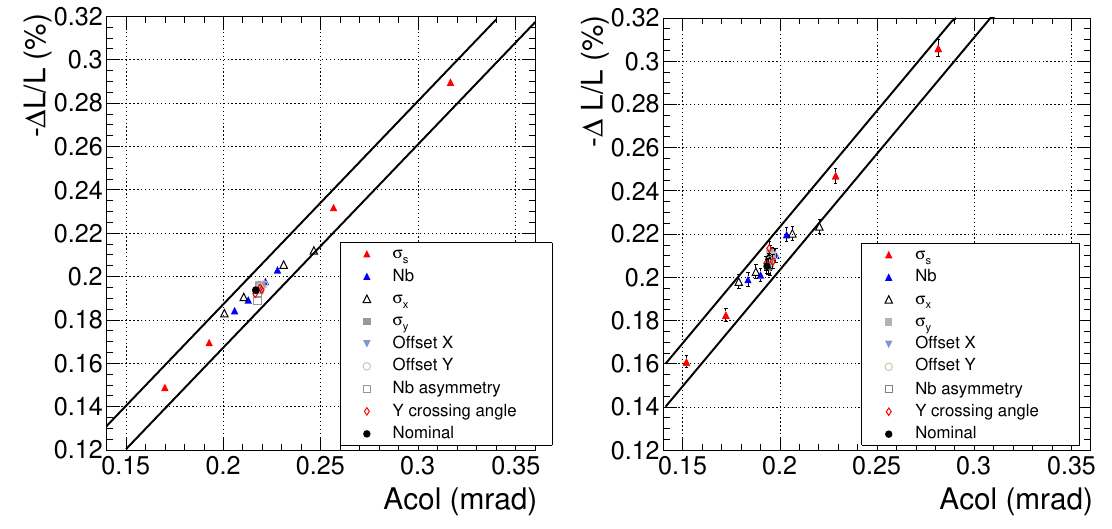
Figure 12 . Luminosity bias as a function of the Acol variable for (left) leading-order Bhabha events and (right) from BHWIDE events. The two solid lines show a (cid:6) 10 (cid:0) 4 uncertainty band around a linear (cid:12)t to all data